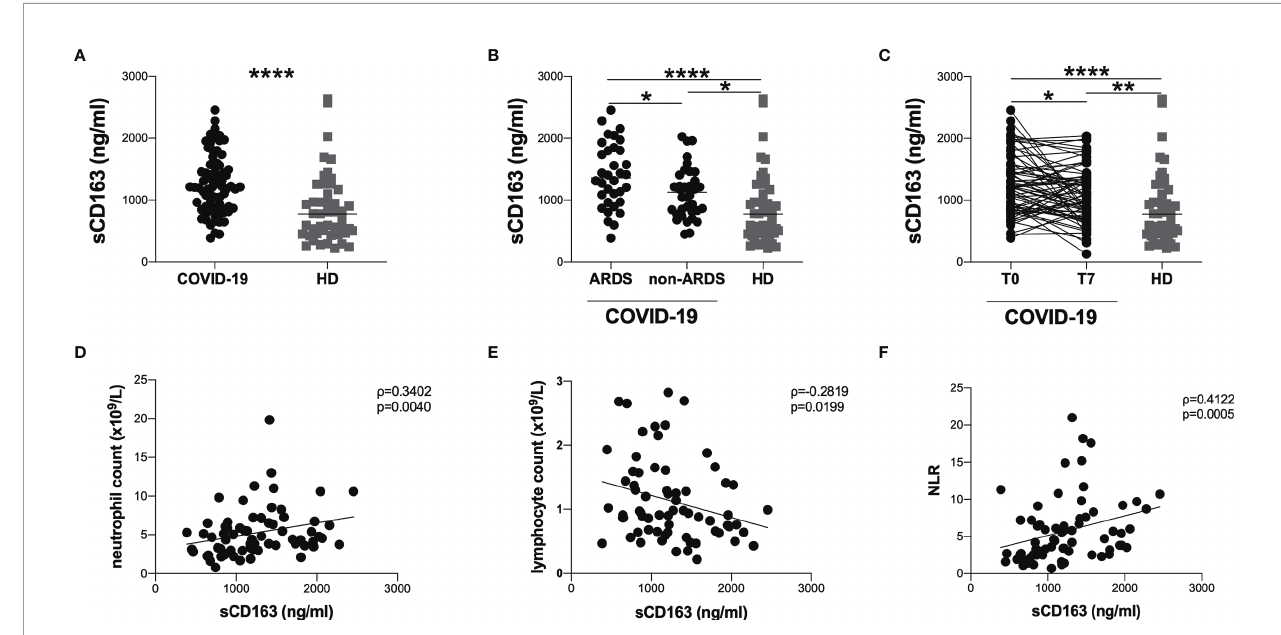
FIGURE 1 | Evaluation of sCD163 plasmatic levels and correlations with clinical data. (A) sCD163 plasmatic levels were evaluated in 70 COVID-19 patients and 47 HD. The differences were evaluated using the nonparametric Mann-Whitney test. Data are shown as median (lines). (B) sCD163 plasmatic levels were evaluated in 34 patients with ARDS (ARDS group) and 36 patients without ARDS (non-ARDS group) using the nonparametric Mann-Whitney test. Both ARDS and non-ARDS groups were compared to HD using the nonparametric Kruskal-Wallis test with Dunn ’ s post-test. Data are shown as median (lines). (C) sCD163 plasmatic levels were longitudinal evaluated in 70 COVID-19 patients at two time-points: at T0 (on hospital admission) and T7 (after seven days from hospital admission) using Wilcoxon test. Both T0 and T7 were compared to HD using the nonparametric Kruskal-Wallis test with Dunn ’ s post-test. Data are shown as median (lines). (D) Positive correlation between sCD163 plasmatic levels and absolute neutrophil count on 70 COVID-19 patients. Linear correlation was evaluated by using the regression test, R 2 = 0.0696, p=0.0273. (E) Negative correlation between sCD163 plasmatic levels and absolute lymphocytes count on 70 COVID-19 patients. Linear correlation was evaluated by using the regression test, R 2 = 0.0702, p=0.0290. (F) Positive correlation between sCD163 plasmatic levels and neutrophil/ lymphocyte ratio (NLR) on 70 COVID-19 patients. Linear correlation was evaluated by using the regression test, R 2 = 0.0843 p=0.0171. All correlations were performed using Spearman test. Spearman coef fi cient ( r ) and statistical signi fi cance (p) are reported in the graphics. **** p> 0.0001; **0.01 < p < 0.001; *0.05 < p